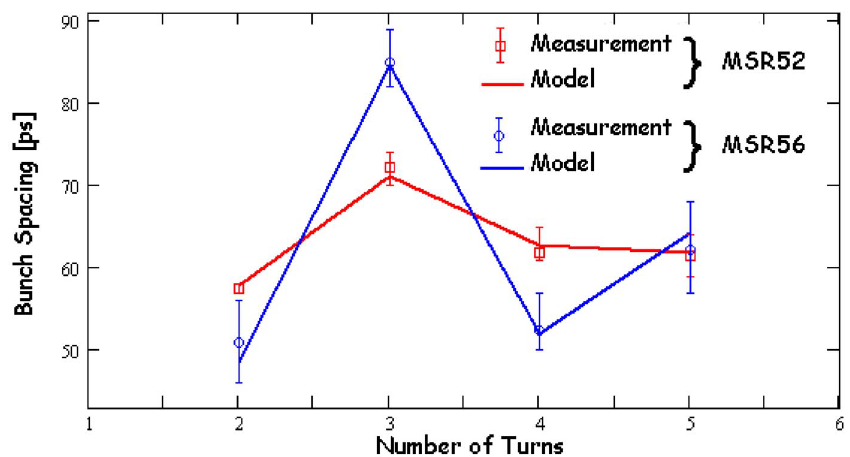
FIG. 26. (Color) Bunch spacing variations after the combination of two pulses as a function of the number of turns observed from two different synchrotron light ports (squares and circles, respectively) in the case of large injection errors. The solid curves correspond to the model predictions in both